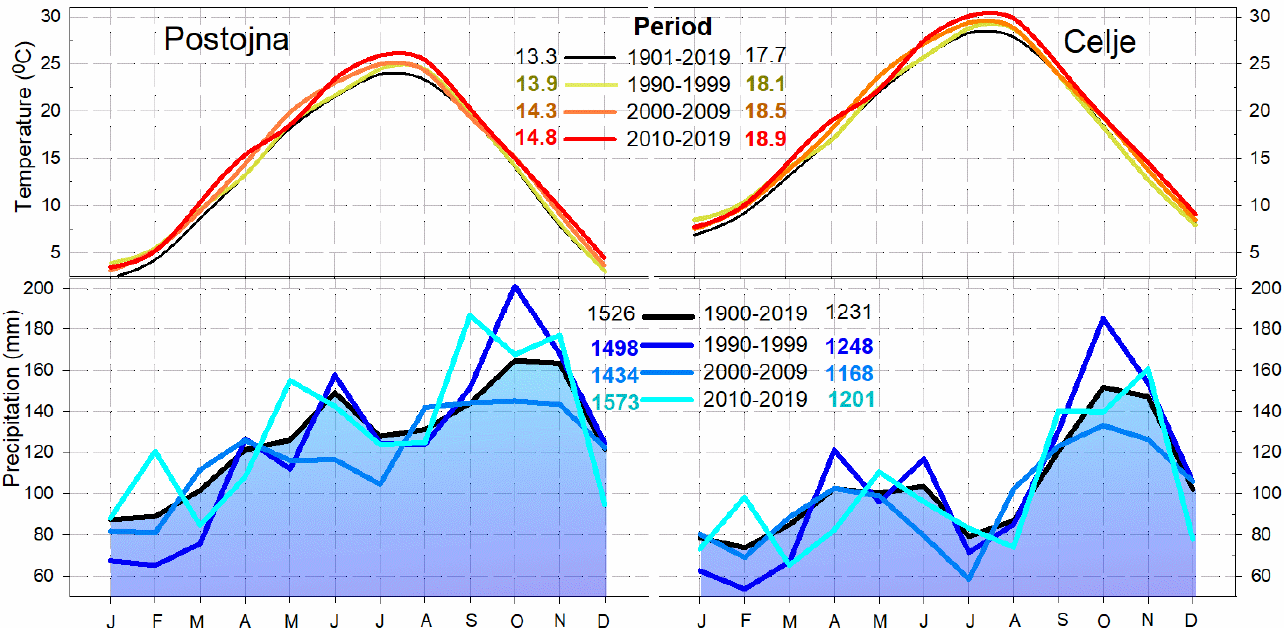
Figure 4. Average monthly temperature and precipitation during the long-term period (1900–2019) and the last three decades (1990–1999/2000–2009/2010–2019). Total annual precipitation and mean annual temperatures are shown near the corresponding period. Source: KNMI.